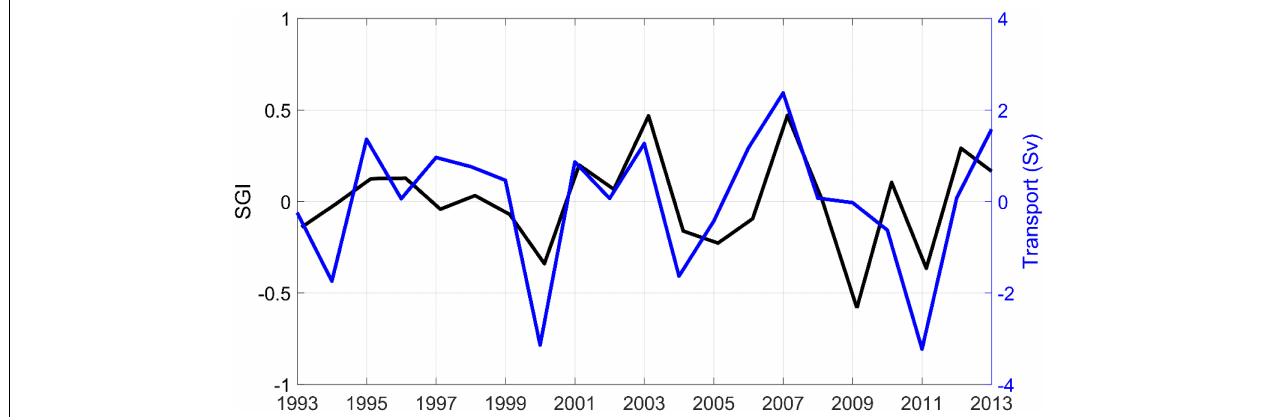
FIGURE 5 | The blue curve represents detrended westward transport at the Tail of the Grand Banks (in Sv, denoted Tail of GB on Figure 1 ) in winter (December, January, and February). The black curve corresponds to A. islandica detrended SGI.